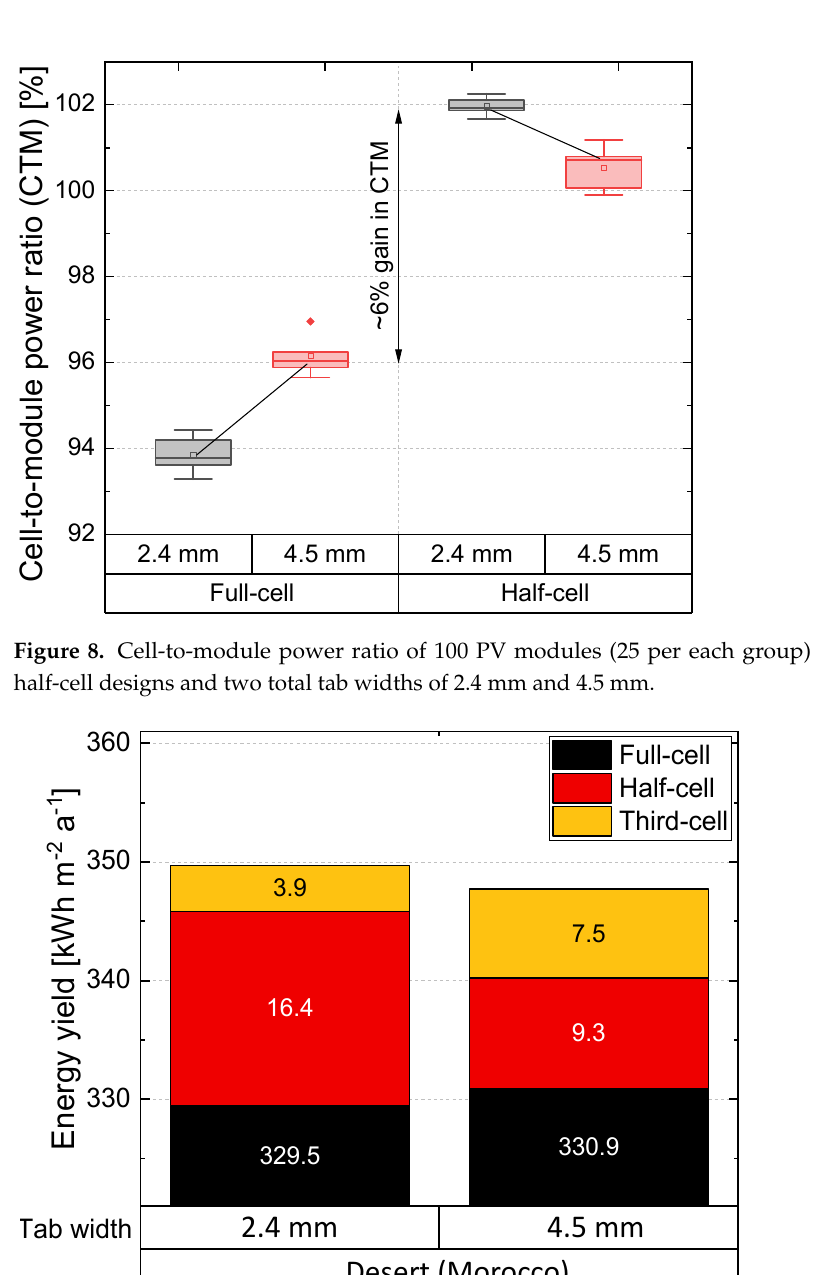
Figure 9. The cumulative energy yield based on full-cell, half-cell and third-cell modules with the same module perimeter and inactive area for two tab width values in Morocco.